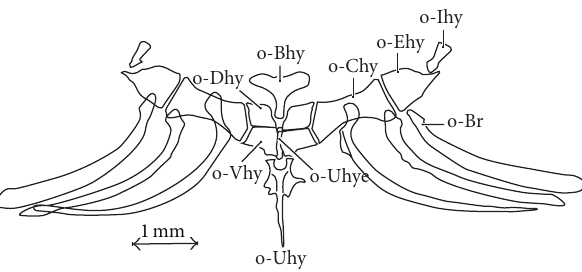
Figure 5: Hyoid arch of Oxynoemacheilus chomanicus . Bhy: basi- hyal; Br: branchiostegal; Chy: ceratohyal; Dhy and Vhy: dorsal and ventral hypohyal; Ehy: epihyal; Ihy: interhyal; Uhy: urohyal; Uhye: extra urohyal.